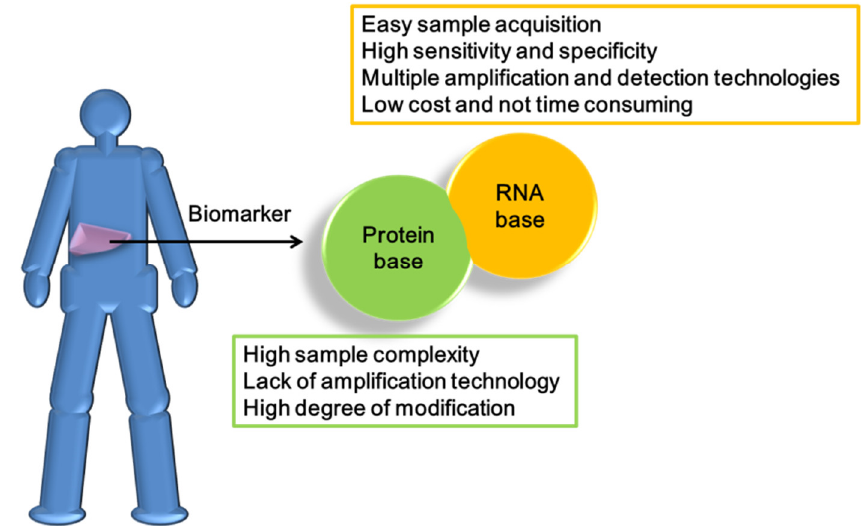
Figure 4. Advantages of RNA as biomarkers in clinical testing.